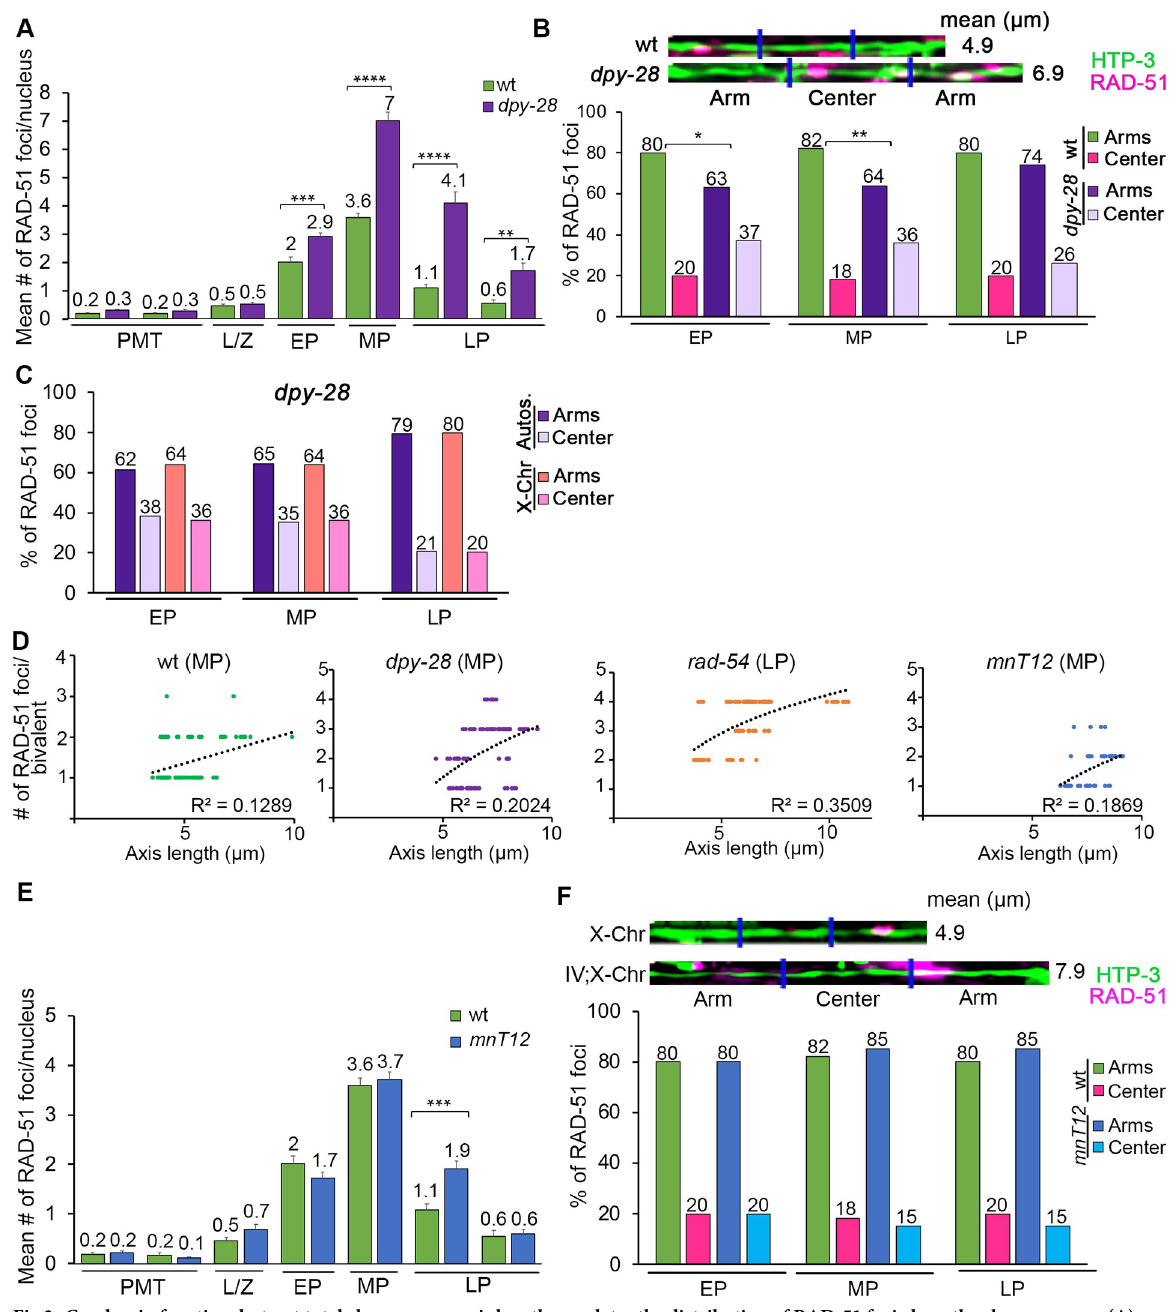
Fig 3. Condensin function, but not total chromosome axis length, regulates the distribution of RAD-51 foci along the chromosomes. (A) Histogram shows the mean number of RAD-51 foci/nucleus (y-axis) scored along each zone in the germlines (x-axis) of dpy-28 mutants compared to wild-type. dpy-28 mutants exhibit a significant increase in the number of RAD-51 foci during pachytene (EP to LP). At least 6 gonads were scored per genotype. Mean number of RAD-51 foci is indicated above each bar graph. Error bars represent SEM from technical repeats for each of two biological replicates. �� p < 0.01, ��� p < 0.001, ���� p < 0.0001 by the two-tailed Mann-Whitney test, 95% C.I. (B) Top shows representative images of linearized chromosomes co-stained with anti-HTP-3 (green) and anti-RAD-51 (magenta). Mean length ( μ m) of the linearized chromosomes is indicated to the right. Bottom, histogram shows the distribution of RAD-51 foci at the center versus the arms of the chromosomes in dpy-28 mutants compared with wild-type. The distribution of RAD-51 foci in dpy-28 mutants is significantly different from wild-type in early and mid-pachytene stages. � p < 0.05, �� p < 0.01 by Fisher’s exact test. (C) Histogram shows the distribution of RAD-51 foci at the center versus the arms of the chromosomes throughout pachytene in dpy-28 mutants comparing autosomes and X chromosomes. Percentages are indicated above each bar graph. Comparisons among different zones scored not significant by Fisher’s exact test, see S2 File. (D) Graphs depicting the relationship between the axis length ( μ m) and the number of RAD-51 foci in the indicated genotypes and stages. Linear regression (black dotted line) and R 2 value are indicated. (E) Histogram shows the mean number of RAD-51 foci/nucleus (y-axis) scored along each zone in